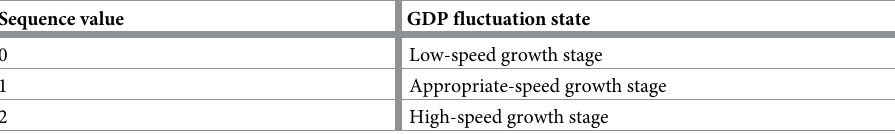
Table 7. GDP fluctuation states that differ in three